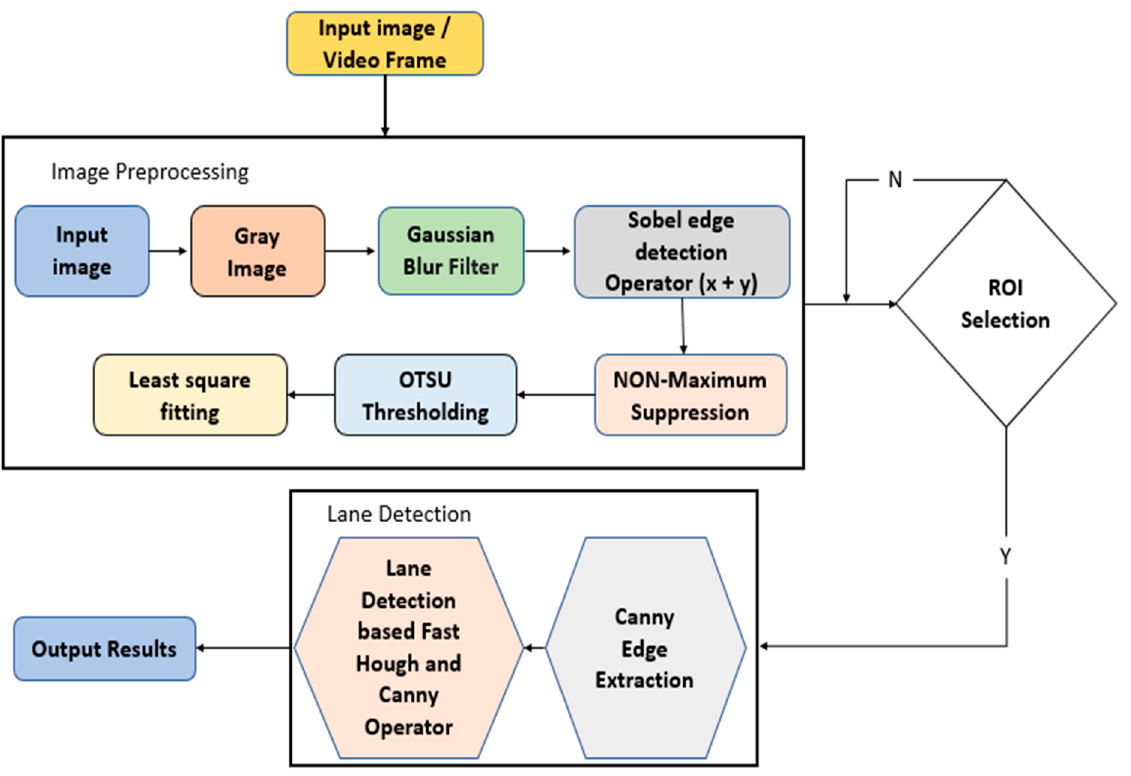
Figure 1. The block diagram of the proposed methodology.